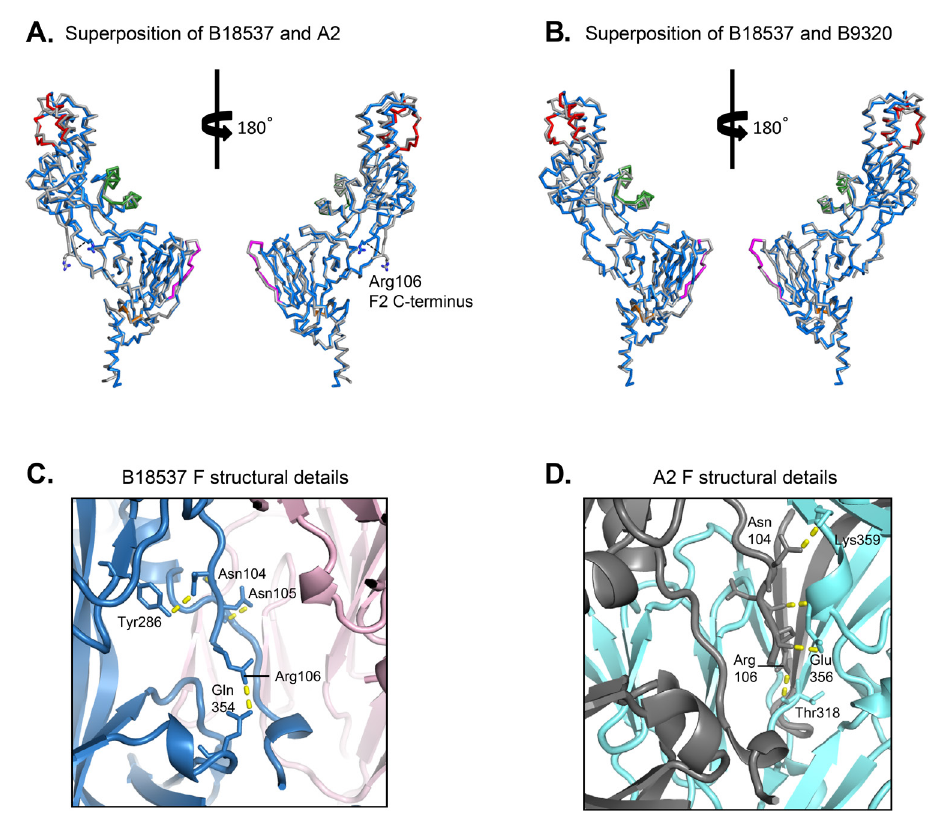
Figure 3. Structural comparison of RSV strain B18537 DS-Cav1 F glycoprotein with A2 DS-Cav1 F (PDB ID: 4MMU) and with B9320 DS-Cav1 F (PDB ID: 5UDE). (A) Structural superposition of a protomer of B18537 F (colored as in Figure 1) with that of A2 (gray) shown in ribbon representation. The 2 structures have a RMSD of 1.18 Å over 454 C α atoms. There is a shift of 8.5 Å between the F2 C-termini of B18537 and A2 F glycoproteins. The F2 C-terminus Arg106 residues of the 2 strains are shown in stick representation with a dashed line indicating the distance between them. (B) Structural superposition of a protomer of B18537 F with that of B9320 (gray). The 2 structures have a RMSD of 1.06 Å over 444 C α at- oms. (C) Close-up view of the F2 C-terminus of the B18537 F structure and its interactions with the fusion peptide and other parts of the same protomer. Shown in pink is an adjacent protomer. (D) Close-up view of the F2 C-terminus of the A2 F structure and its interactions with an adjacent protomer (cyan). In (C) and (D), yellow dashes indicate